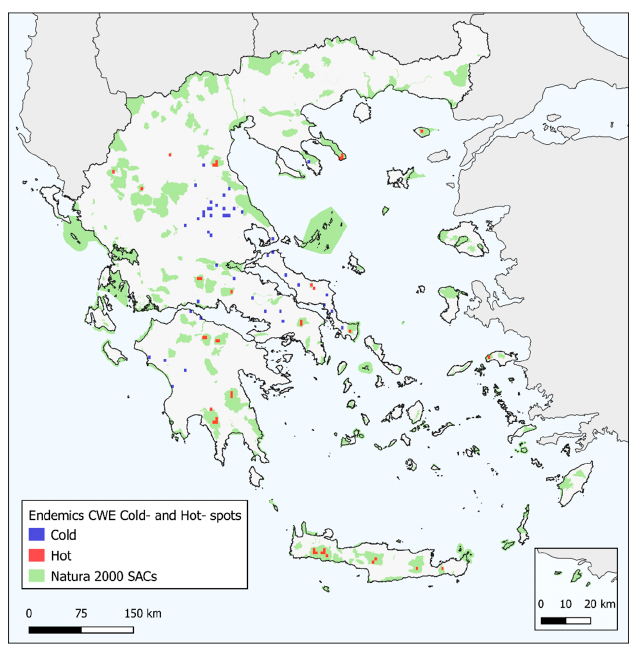
Figure 5. Red colouring indicates cells with Level-1 (top-1%) CWE END values. Blue colouring indicates cells with values from the 1% percentile (CWE END coldspots). Green polygons depict the Natura 2000 SACs in Greece.